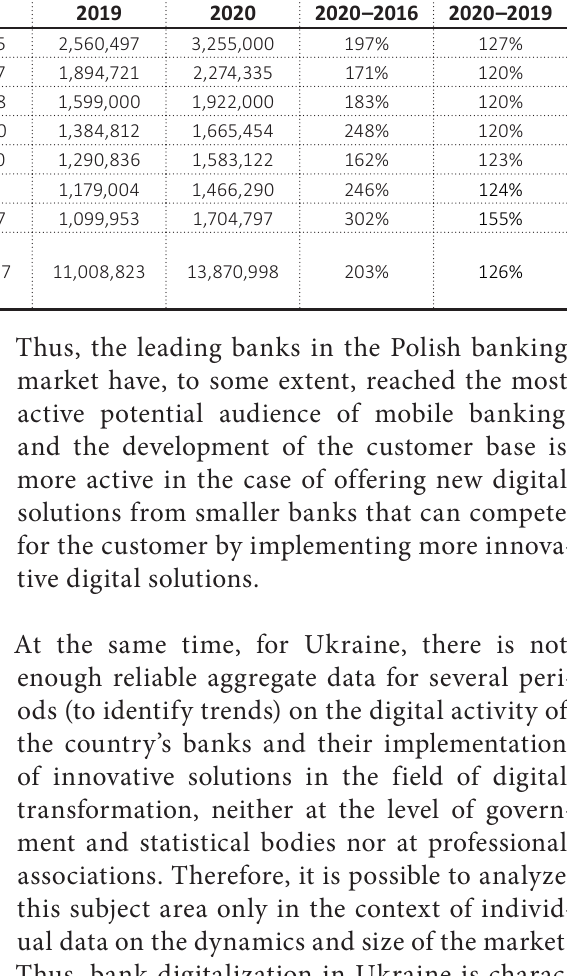
Table 1. Number of users of mobile banking services in Poland in 2016–2020 Bank